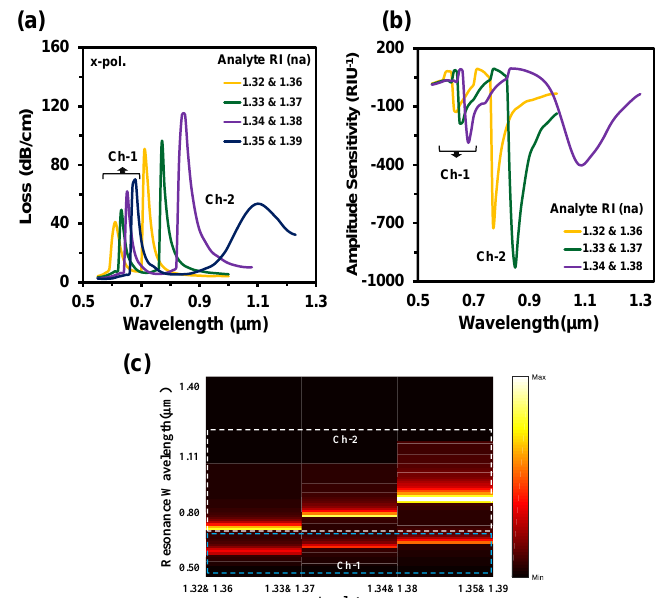
Figure 5. ( a ) CL spectra, ( b ) Amplitude sensitivity, and ( c ) normalized 2D map of CL intensity of the proposed sensor when the analyte RI of Ch-1 and Ch-2 varies simultaneously. The WSs were 2000 nm/RIU, 2000 nm/RIU, and 3000 nm/RIU for RI 1.32, 1.33, and 1.34, respectively at Ch-1 of the proposed sensor with an average WS of 2333 nm/RIU. Similarly, at Ch-2 the obtained WSs were 6000 nm/RIU, 8000 nm/RIU, and 25,000 nm/RIU for RI 1.36, 1.37, and 1.38, respectively. The acquired average WS was 13,000 nm/RIU for Ch-2. This simple hexagonal PCF sensor could detect analyte RIs from 1.32 to 1.39. Nu- merous biomolecules and biochemicals are within this range, such as intestinal mucosa (human) = 1.329–1.338, urine (human) = 1.3415–1.3464, ethanol = 1.361, commercial hydro- carbon mixtures = 1.366, various cancerous cells = 1.36–1.40, and so on [10,22,35]. The AS method is cost-effective due to it being free from wavelength manipulation as well as